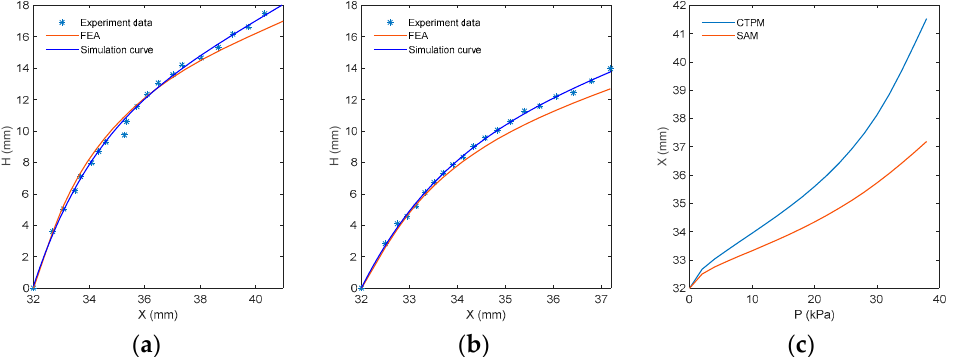
Figure 19. Horizontal distance–vertical displacement and air pressure–horizontal distance diagrams of the outer ring points (attachment point of SAM’s outer ring sensor and the corresponding point of CTPM’s outer ring sensor attachment point). ( a , b ) represent the outer ring point displacement path curves of CTPM and SAM, respectively, where experimental data represent the measured point displacement results, and FEA represents the simulated point displacement path curve. The simulation curve represents the curve fitted according to the actual measurement points. ( c ) represents the pressure level position relationship curve obtained from CTPM and SAM finite-element analysis.